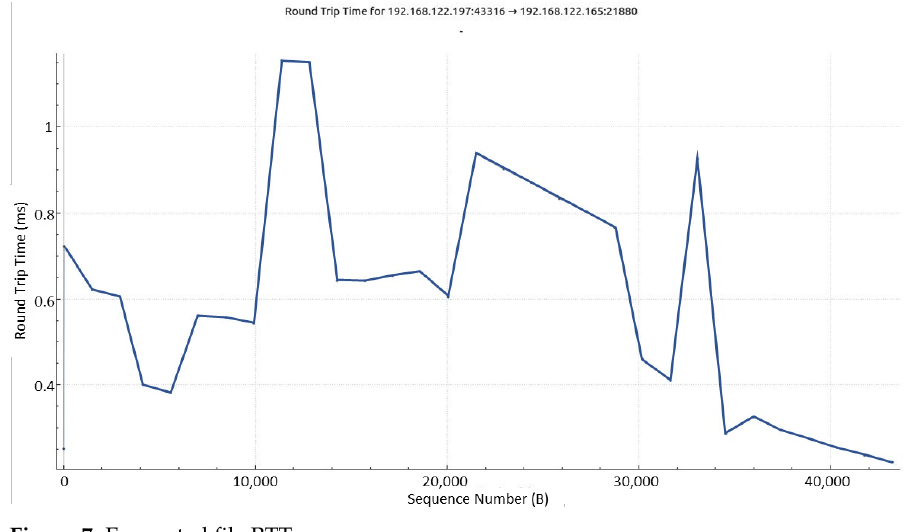
Figure 7. Encrypted file RTT.